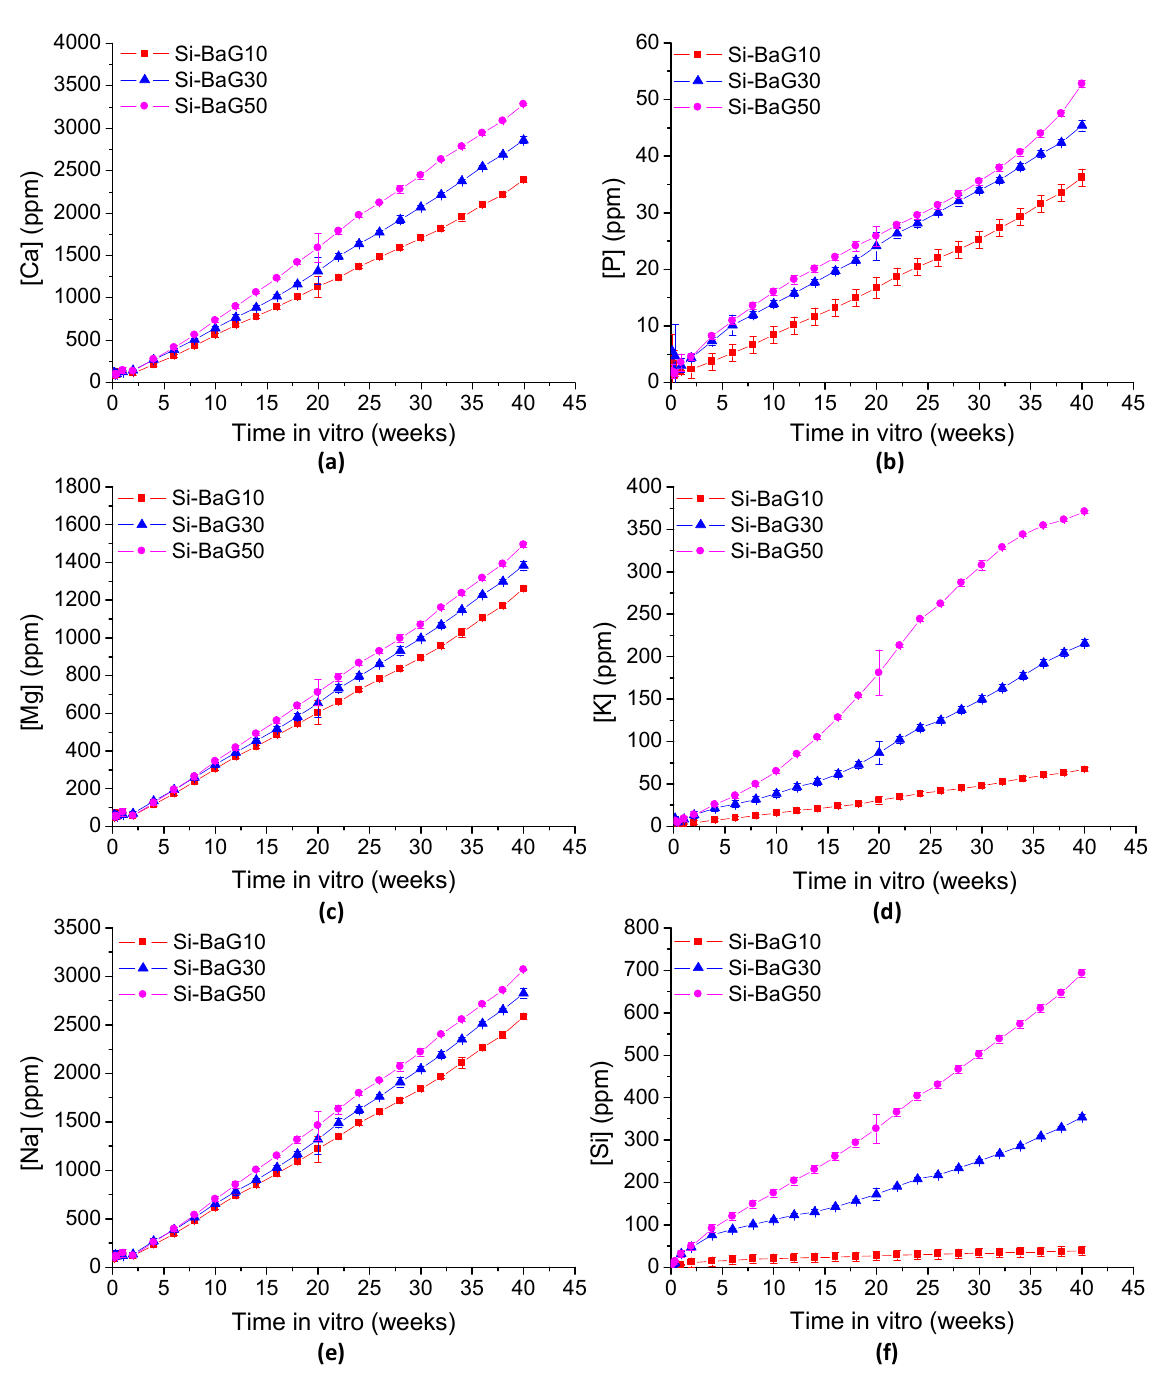
Figure 5. The ( a ) calcium, ( b ) phosphorus, ( c ) magnesium, ( d ) potassium, ( e ) sodium, and ( f ) silicon ions released from the Si-BaG composites into the Tris solution over 40 weeks.